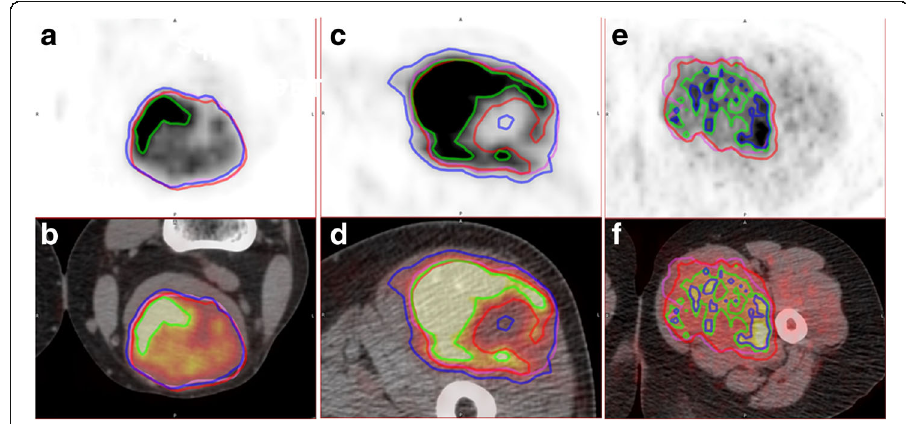
Fig. 3 Images of representative cases ( a, c, and e axial 18 F-FDG PET image; b, d, and f axial fusion image). a, b A 54-year-old male with synovival sarcoma in the left popliteal fossa (SUV max 28.71). The ratios of MTV to GTV for MO-PET, SUV 2.0, 30% SUV max , and PET Edge ™ are 1.05, 1.06, 0.25, and 0.97, respectively. c, d A 64-year-old male with extraskeletal osteosarcoma in the right thigh (SUV max 27.77). The ratios of MTV to GTV for MO-PET, SUV 2.0, 30% SUV max , and PET Edge ™ are 0.90, 1.62, 0.57, and 1.17, respectively. e, f A 42-year-old female with pleomorphic leiomyosarcoma in the left thigh (SUV max 5.47). The ratios of MTV to GTV for MO-PET, SUV 2.0, 30% SUV max , and PET Edge ™ are 1.13, 0.24, 0.46, and 0.99, respectively. Red line, MO-PET; blue line, SUV 2.0; green line, 30% SUV max ; pink line, PET Edge